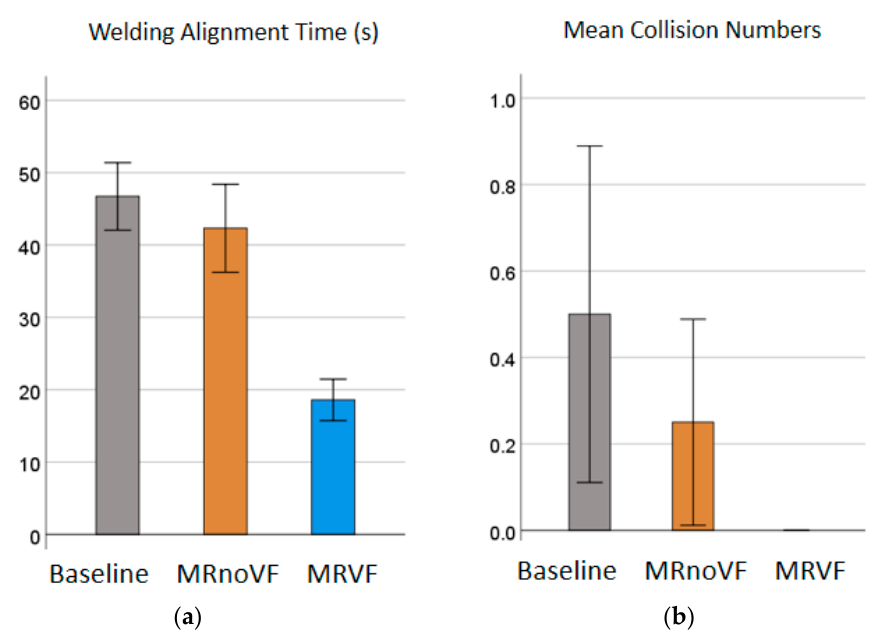
Figure 10. ( a ) The average number of collisions for each of the three conditions (baseline, MRnoVF, and MRVF) in the flat position tele-welding tasks. The prevention effect in MRVF eliminated all unintentional contacts. ( b ) The amount of time participants spent aligning the torch tip across all conditions. The alignment time serves as a major component of task completion time.